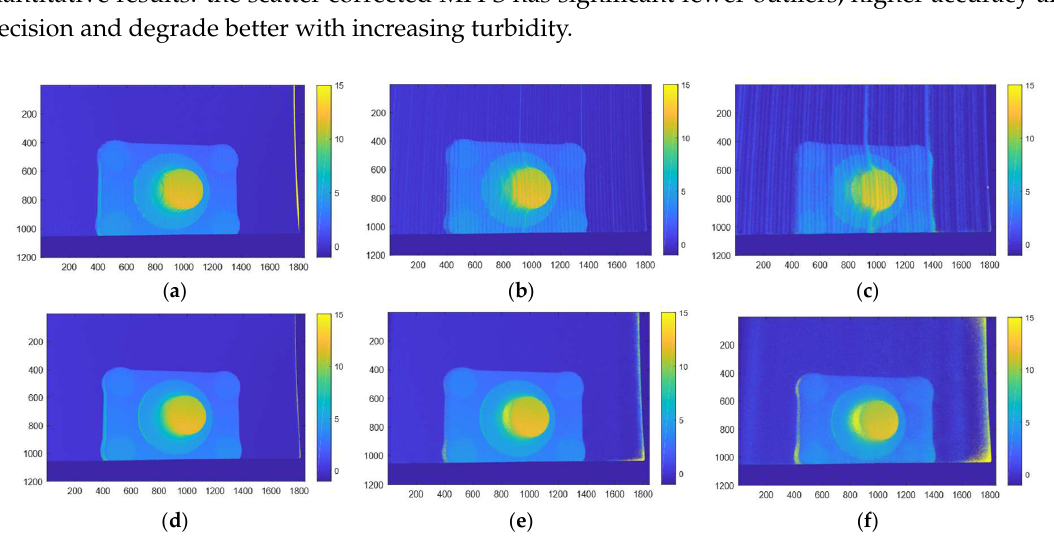
Table 2. Results from 𝜆 (cid:2870) = 1.1 m. We show the results for the intermediate steps in the MFPS algorithm, i.e., the frequencies 1, 8 and 64. Description of the columns is given in Table 1.